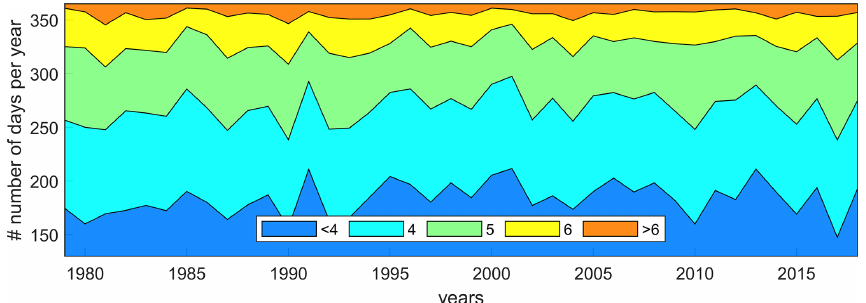
Figure 9. The number of days with the Beaufort scale: < 4 (gentle breeze), 4 (moderate breeze), 5 (fresh breeze), 6 (strong breeze), and > 6 (gale force) as simulated by ERA5 for the area of interest. Data are based on the average wind speed for the intermediate